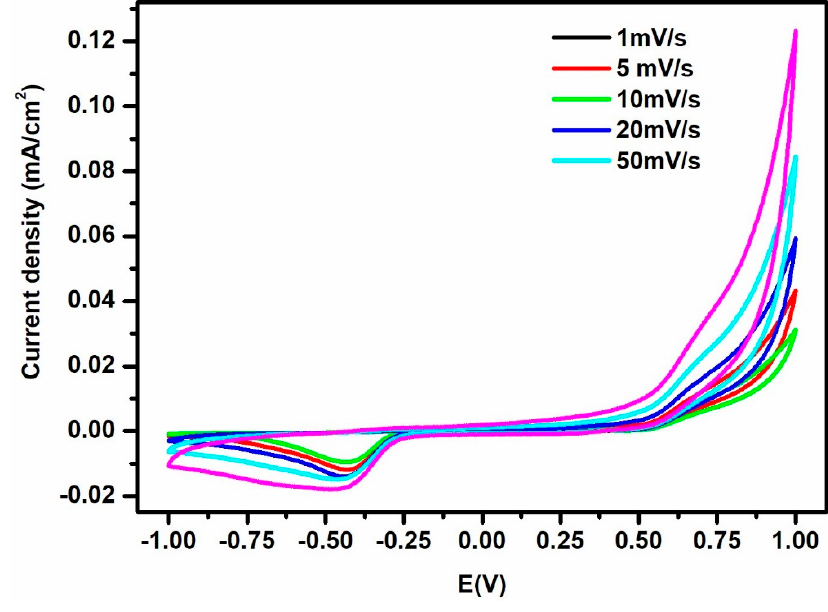
Figure 8. Cyclic voltammogram of HRG@ZrO 2 nanocomposite with different sweep rate.